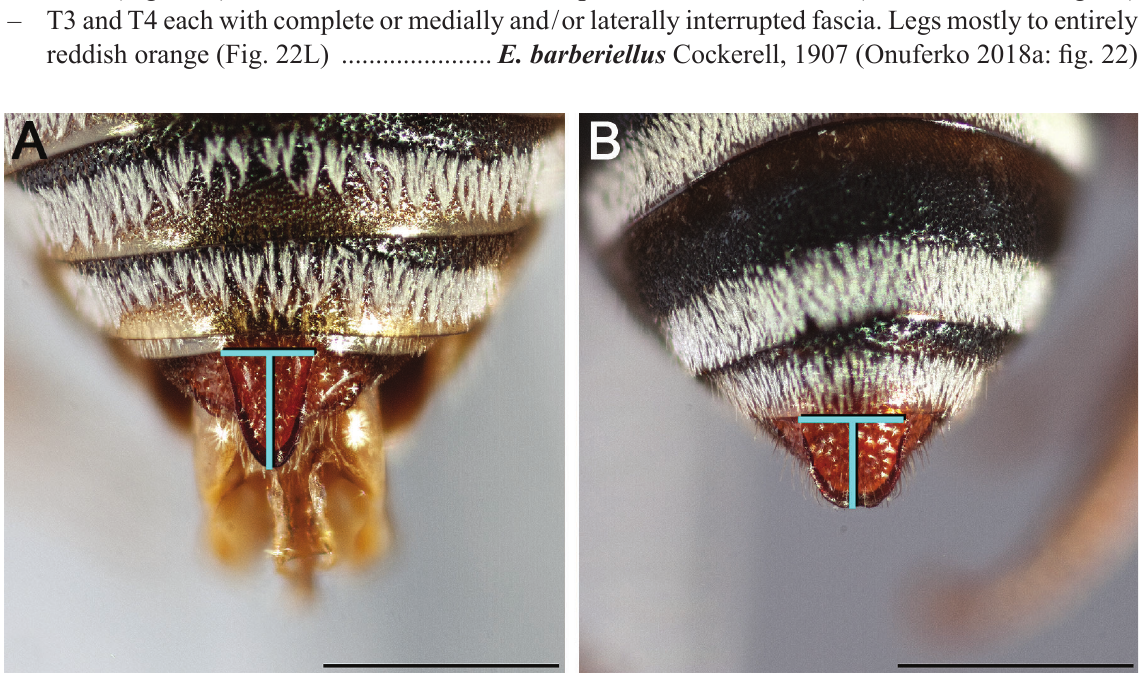
Fig. 28. Pygidial plate of male, dorsal view. A . E. australis Mitchell, 1962 (longer than wide and apically narrowed). B . E. brumleyi Onuferko, 2018, allotype (about as long as wide and broadly rounded apically). Scale bars = 1